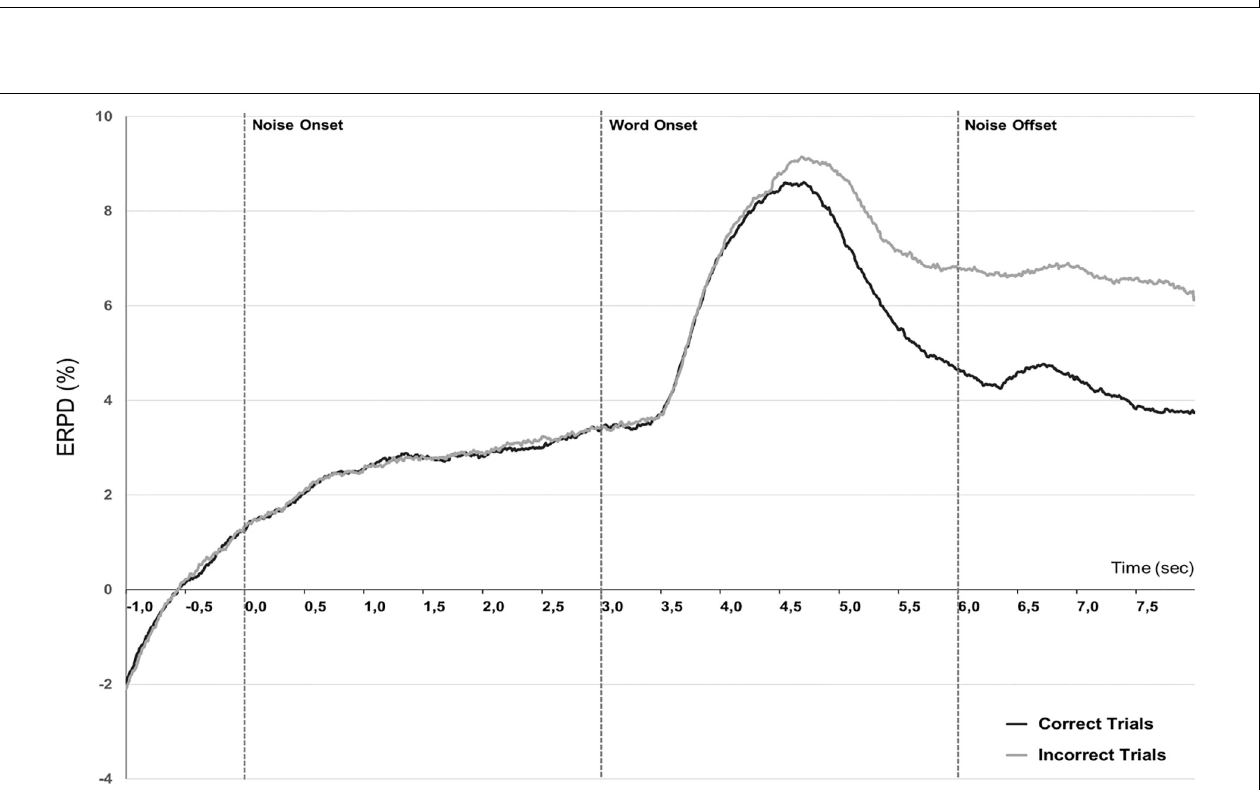
FIGURE 5 | Performance effect. Grand-averaged ( N = 10) pupillometry traces showing percent change in event-related pupil dilation (ERPD) for correctly recognized words (black line) or incorrect trials (gray line), independently of the listening condition.